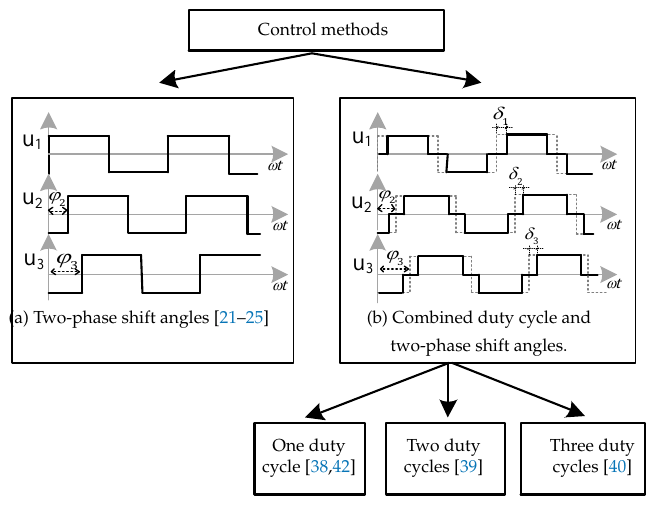
Figure 6. Control methods of the TAB converter.